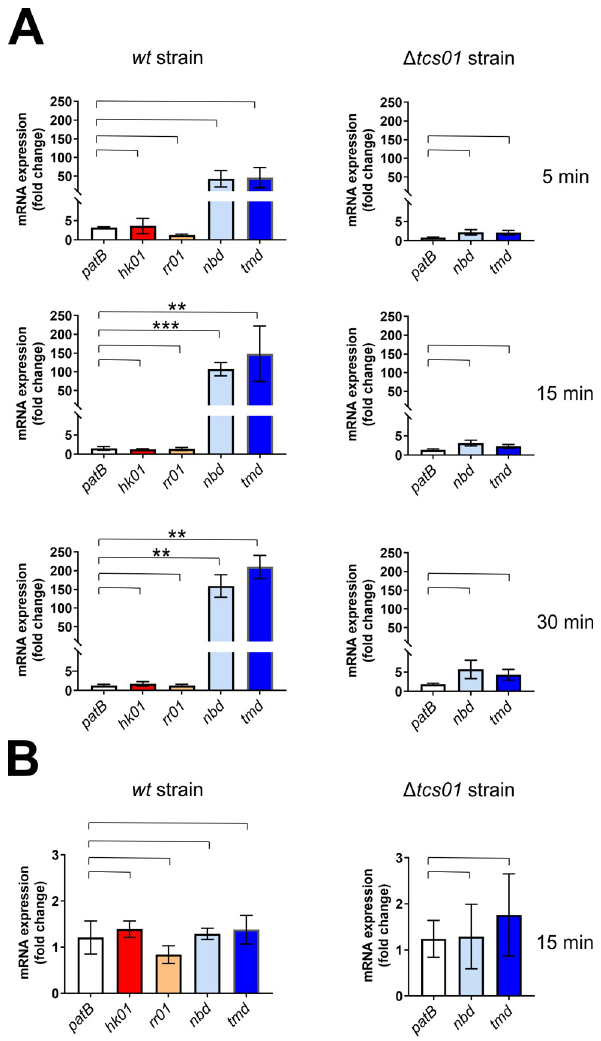
Fig 2. Quantification of gene expression in S . pneumoniae in the presence of bacitracin (A) or vancomycin (B). (A) After bacitracin treatment (1 μ g/ml for 5, 15 and 30 min), the amount of mRNAs extracted from D39 strains was quantified by qPCR relatively to a control without bacitracin. The ABC genes are in blue tone colors, while the tcs 01 genes are shown in red and orange colors. The patB gene was used as a control that does not respond to bacitracin treatment in the experiment. Data are the average of biological replicates (n = 6 for time 5 and 30 min; n = 8 for time 15 min) and the standard deviation of the mean is shown. Statistical significance was calculated by Student´s t-test with Welch’s correction between the conditions indicated with brackets. In the absence of label above the bracket, the p value is above 0.05 and considered not significant, whereas statistically significant differences are indicated with �� ( p � 0.01) and ��� ( p � 0.001). (B) After vancomycin (375 ng/ml for 15 min) treatment, the amount of mRNAs extracted from D39 strains was quantified by qPCR relatively to a control without vancomycin. Data are the average of biological replicates (n = 8) and the standard deviation of the mean is shown. Statistical significance was calculated by Student´s t-test with Welch’s correction as in